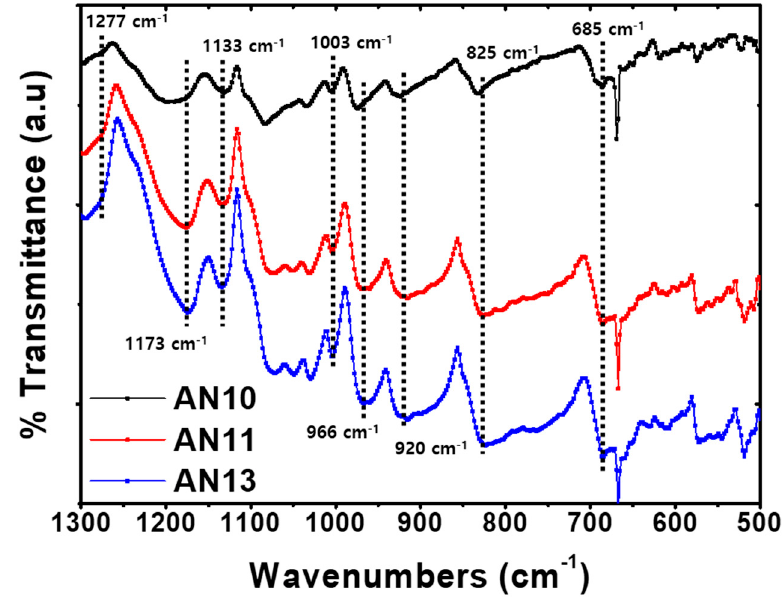
Figure 3. FTIR spectra of spin-coated AN10, AN11, and AN13 PEDOT:PSS films.